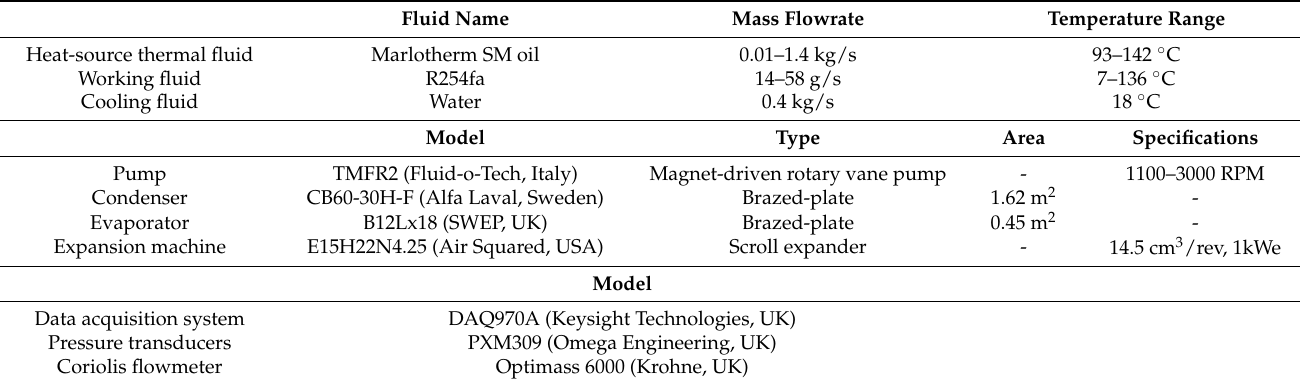
Table 1. Components specification of the ORC test prototype